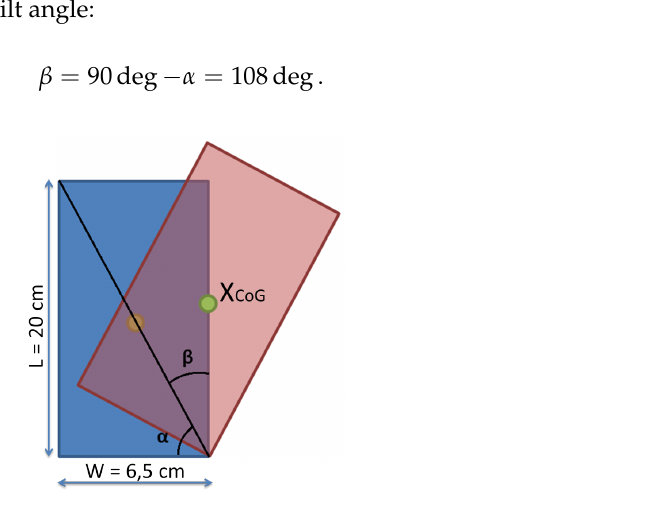
Figure 9. Scheme representing the angles that must be obtained to calculate the limit tilt angle in which the bottle can be placed before